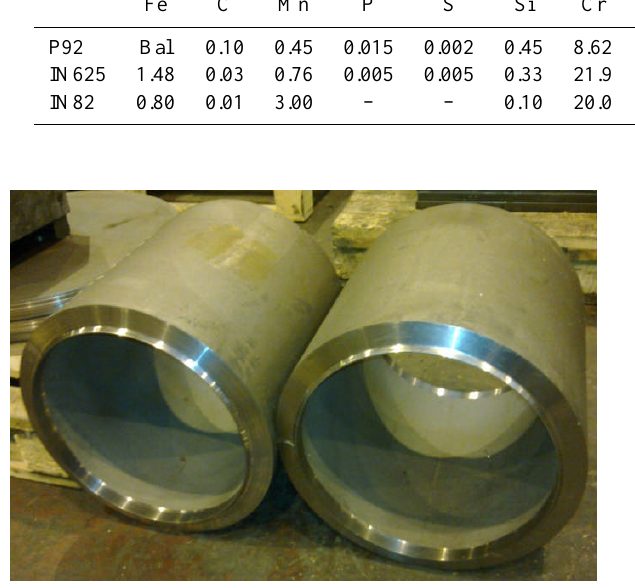
Figure 1. P92 pipe before welding. Figure 2. P92 pipe during welding. Figure 2. P92 pipe during